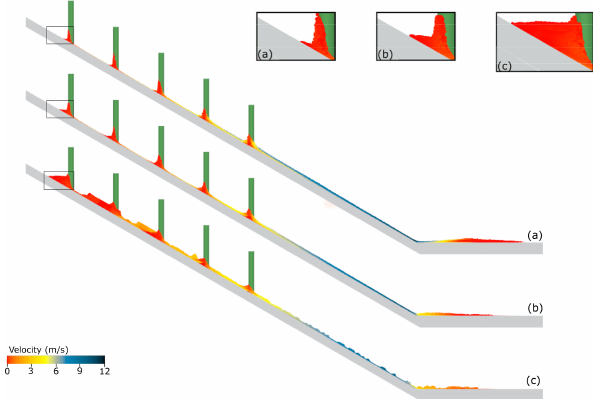
Figure 4. Profile of accumulated snow for different flow regimes: (a) Case 1, (b) Case 2, and (c) Case 3, regular staggered forest at t = 10s, e = 8m, d = 1m, and v 0 = 10ms − 1